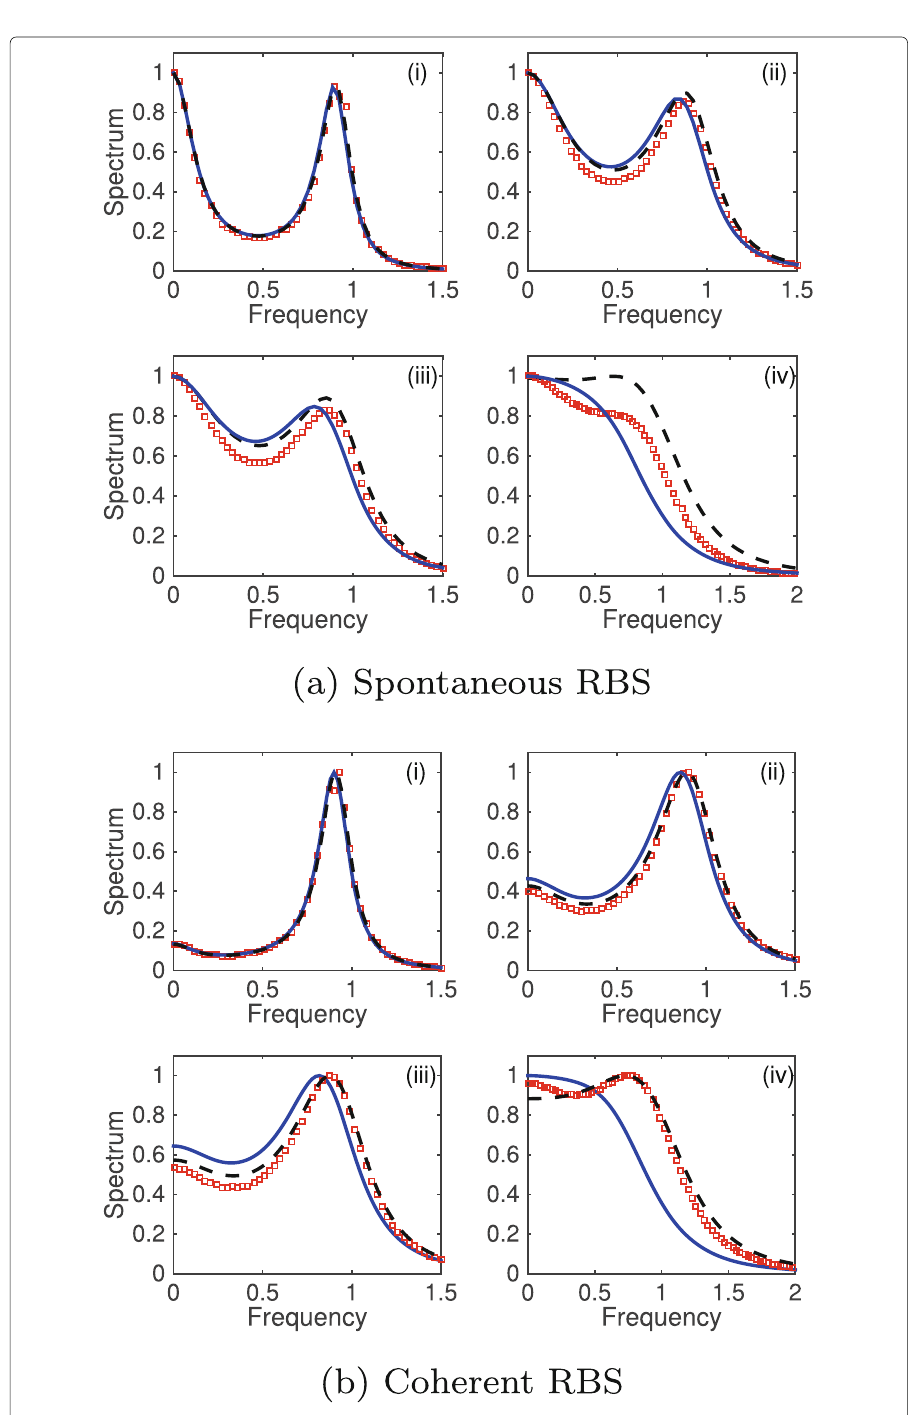
Fig. 3 Spectra of the spontaneous and coherent RBS, when (i) Kn = 0.02, (ii) Kn = 0.04, (iii) Kn = 0.05, and (iv) Kn = 0.1. Solid and dashed lines are results from NS and Burnett equations, respectively. In this and subsequent figures, squares represent results from the LBE for Maxwellian gases if without specification